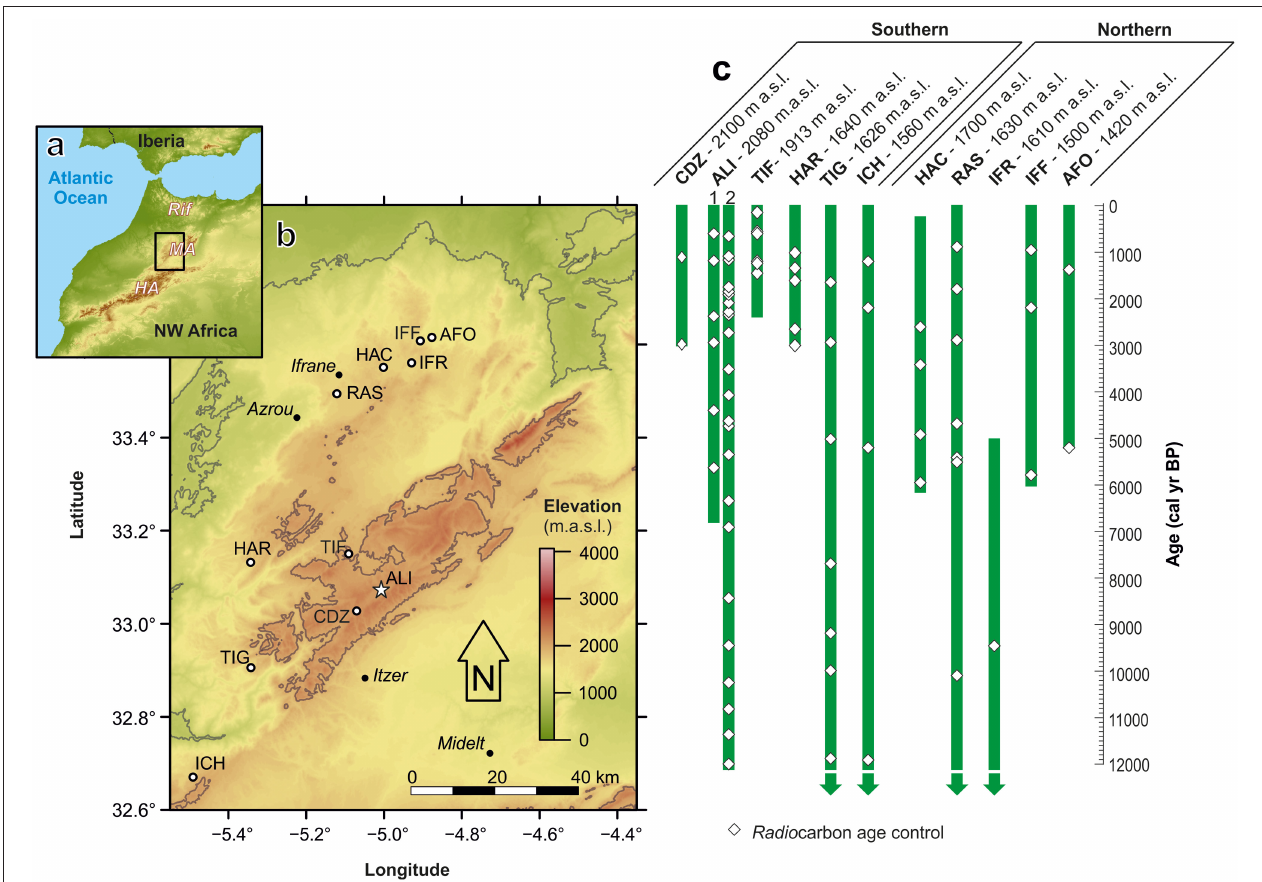
FIGURE 1 | The study region and location of pollen records, showing: (a) the location of the Middle Atlas (MA), High Atlas (HA) and Rif mountain ranges in Morocco; (b) the western Middle Atlas and the location of the study site and other Holocene pollen studies cited in the text; and (c) length and chronological control of dated pollen records for the Middle Atlas. Key to sites: AFO—Dayat Afourgagh (Lamb et al., 1991); ALI—Lake Sidi Ali (1—Sidi Ali sub-basin, Lamb et al., 1999; 2—Sidi Ali deep lake, this study); CDZ—Col du Zad (Reille, 1976); HAC—Dayet Hachlaff (Nourelbait et al., 2016); HAR—Taguelmam N’Harcha (Lamb et al., 1991); ICH—Ait Ichou (Tabel et al., 2016); IFF—Dayat Iffir (Lamb et al., 1991); IFR—Dayat Ifrah (Rhoujjati et al., 2010; Reddad et al., 2013); RAS—Ras el Ma (Nourelbait et al., 2014); TIF—Tifounassine (Cheddadi et al., 2015); TIG—Tigalmamine (Lamb et al., 1989, 1995; Lamb and van der Kaars, 1995; Cheddadi et al.,